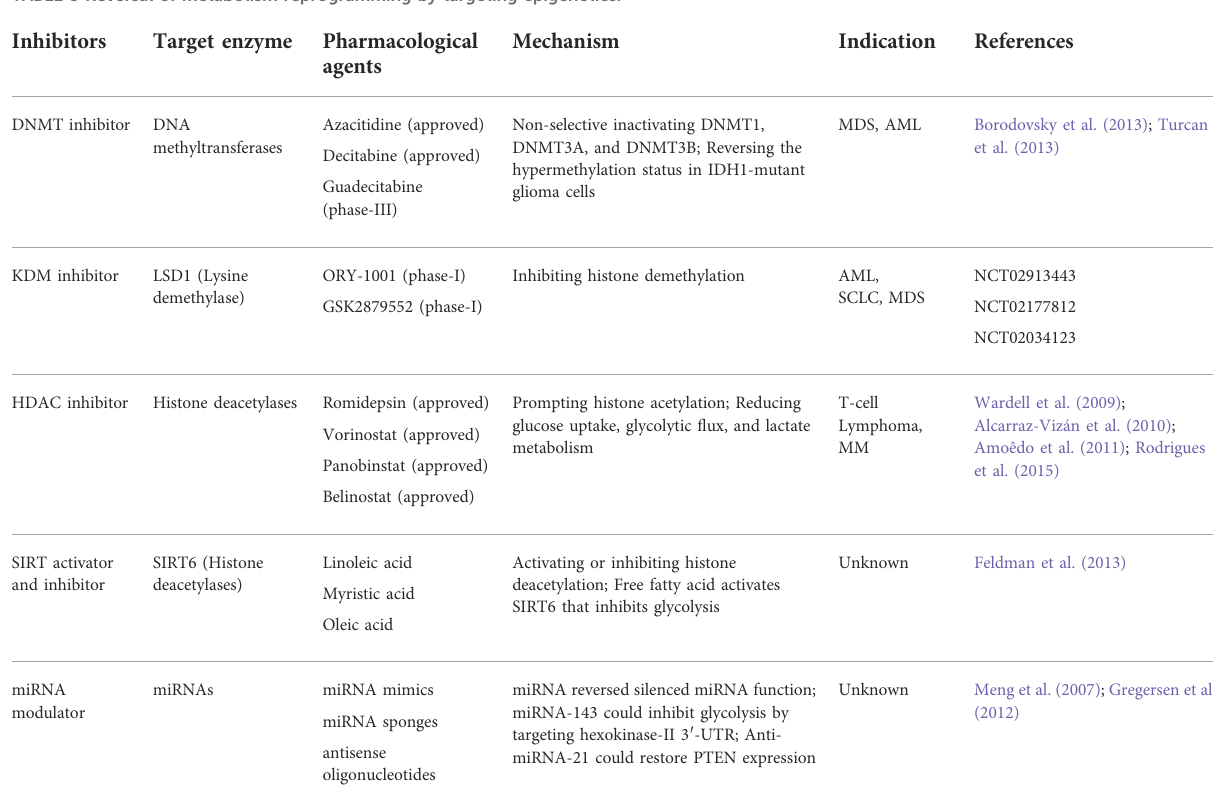
TABLE 5 Reversal of metabolism reprogramming by targeting